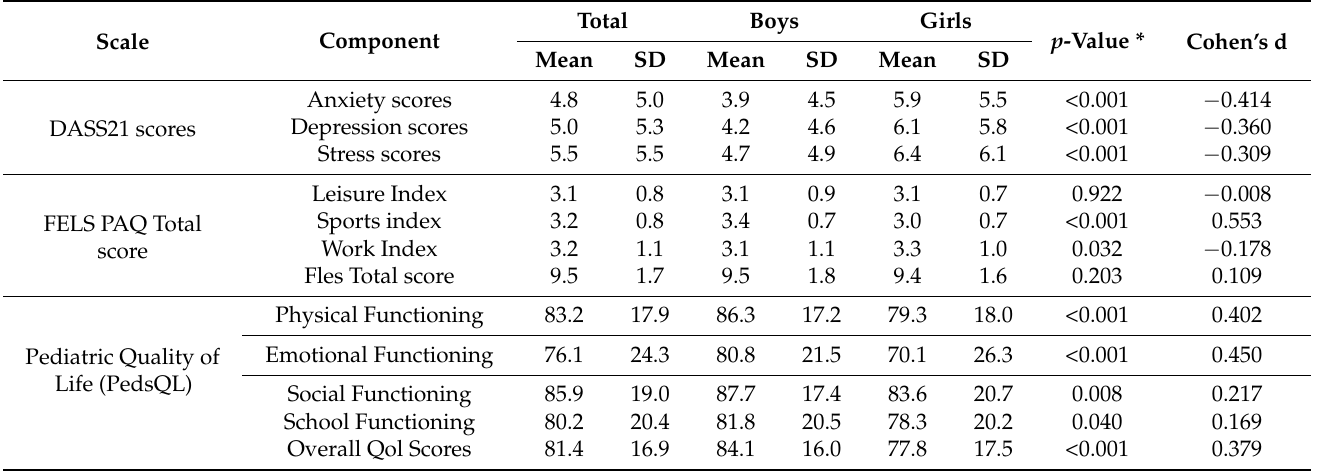
Table 2. Descriptive statistics of mental health, physical activity, and quality of life for boys (n = 337) and girls (n = 264).